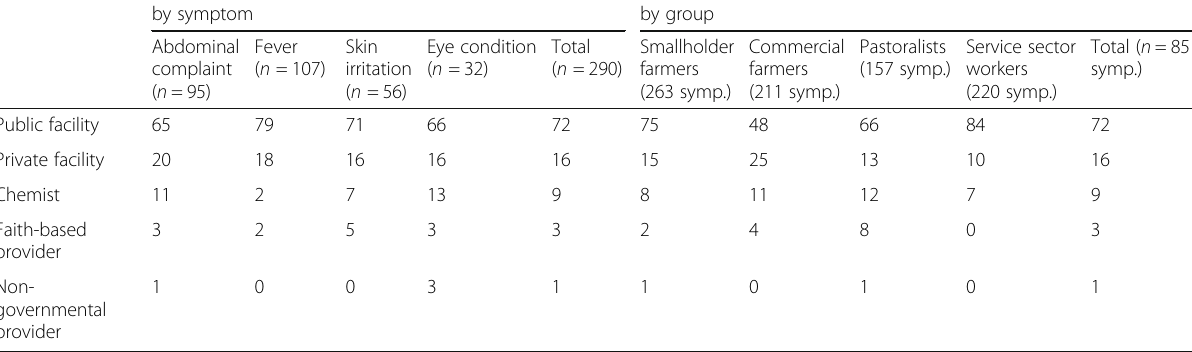
Table 5 Health-seeking behaviour, stratified by symptoms and groups [%] by symptom by